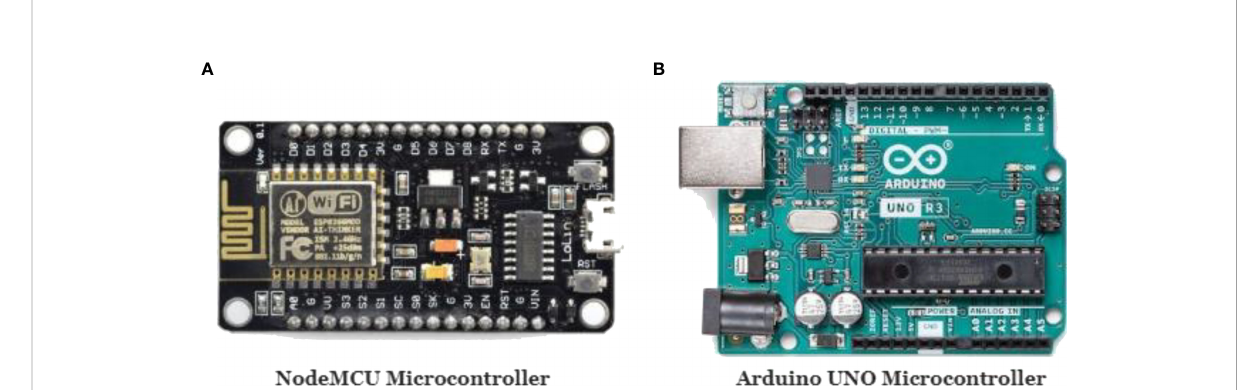
FIGURE 3 (A) NodeMCU microcontroller, (B) Arduino U.N.O.